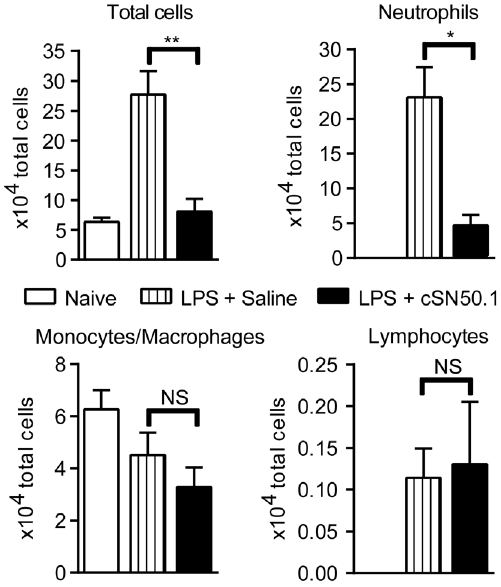
Figure 5. LPS-induced cellular trafficking to lungs is reduced in NTM-treated mice. Cell counts in BAL fluid collected from unchallenged mice (naı¨ve) and 6 h after direct airway exposure to LPS, with i.p. NTM peptide (cSN50.1) or diluent control (saline) treatment. The LPS-induced increase in total cells is comprised primarily of neutrophils. Neutrophil trafficking to BAL is significantly reduced by NTM treatment while monocytes/macrophages and lymphocytes are not affected. Data are presented as mean 6 standard error, n =4 naı¨ve and 5–7 NTM- or saline-treated animals/group from two independent experiments. * p , 0.05, ** p , 0.005 by Mann-Whitney U test comparing LPS-challenged groups.